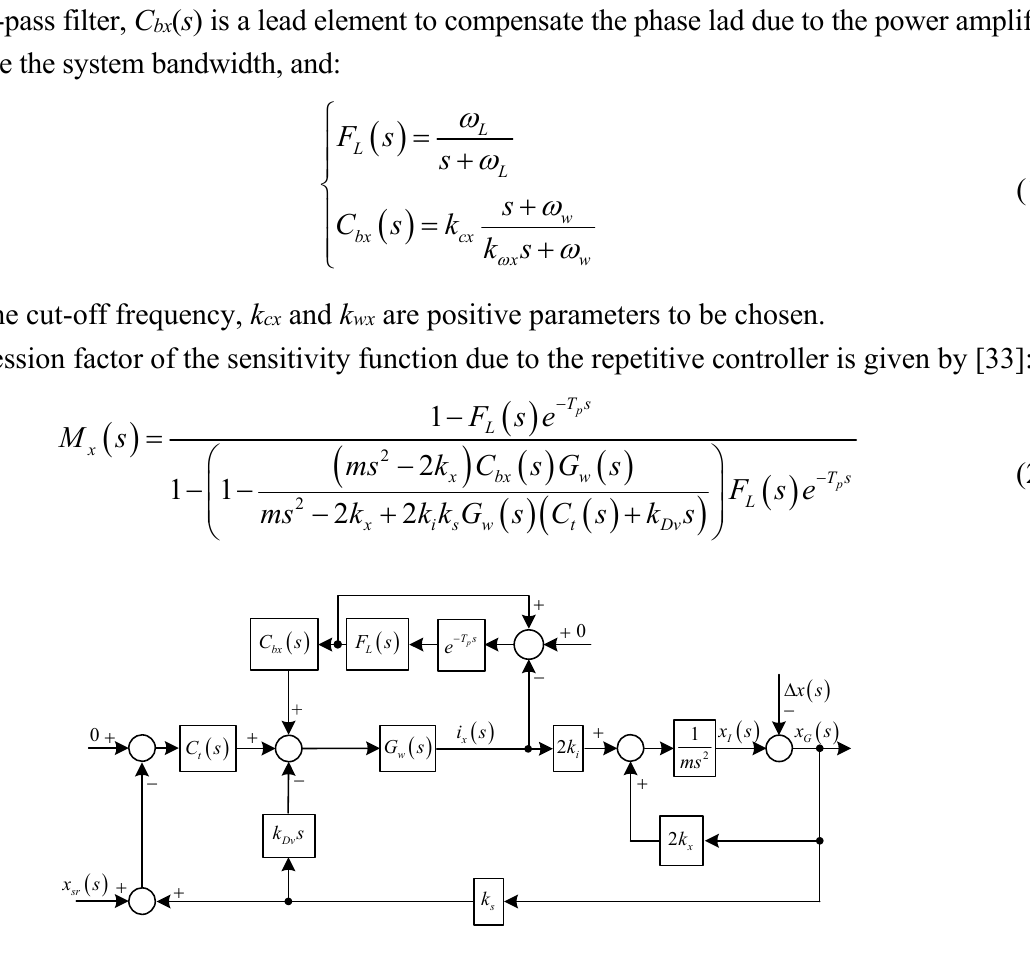
Figure 10. Diagram of the translational subsystem in the X direction with the repetitive